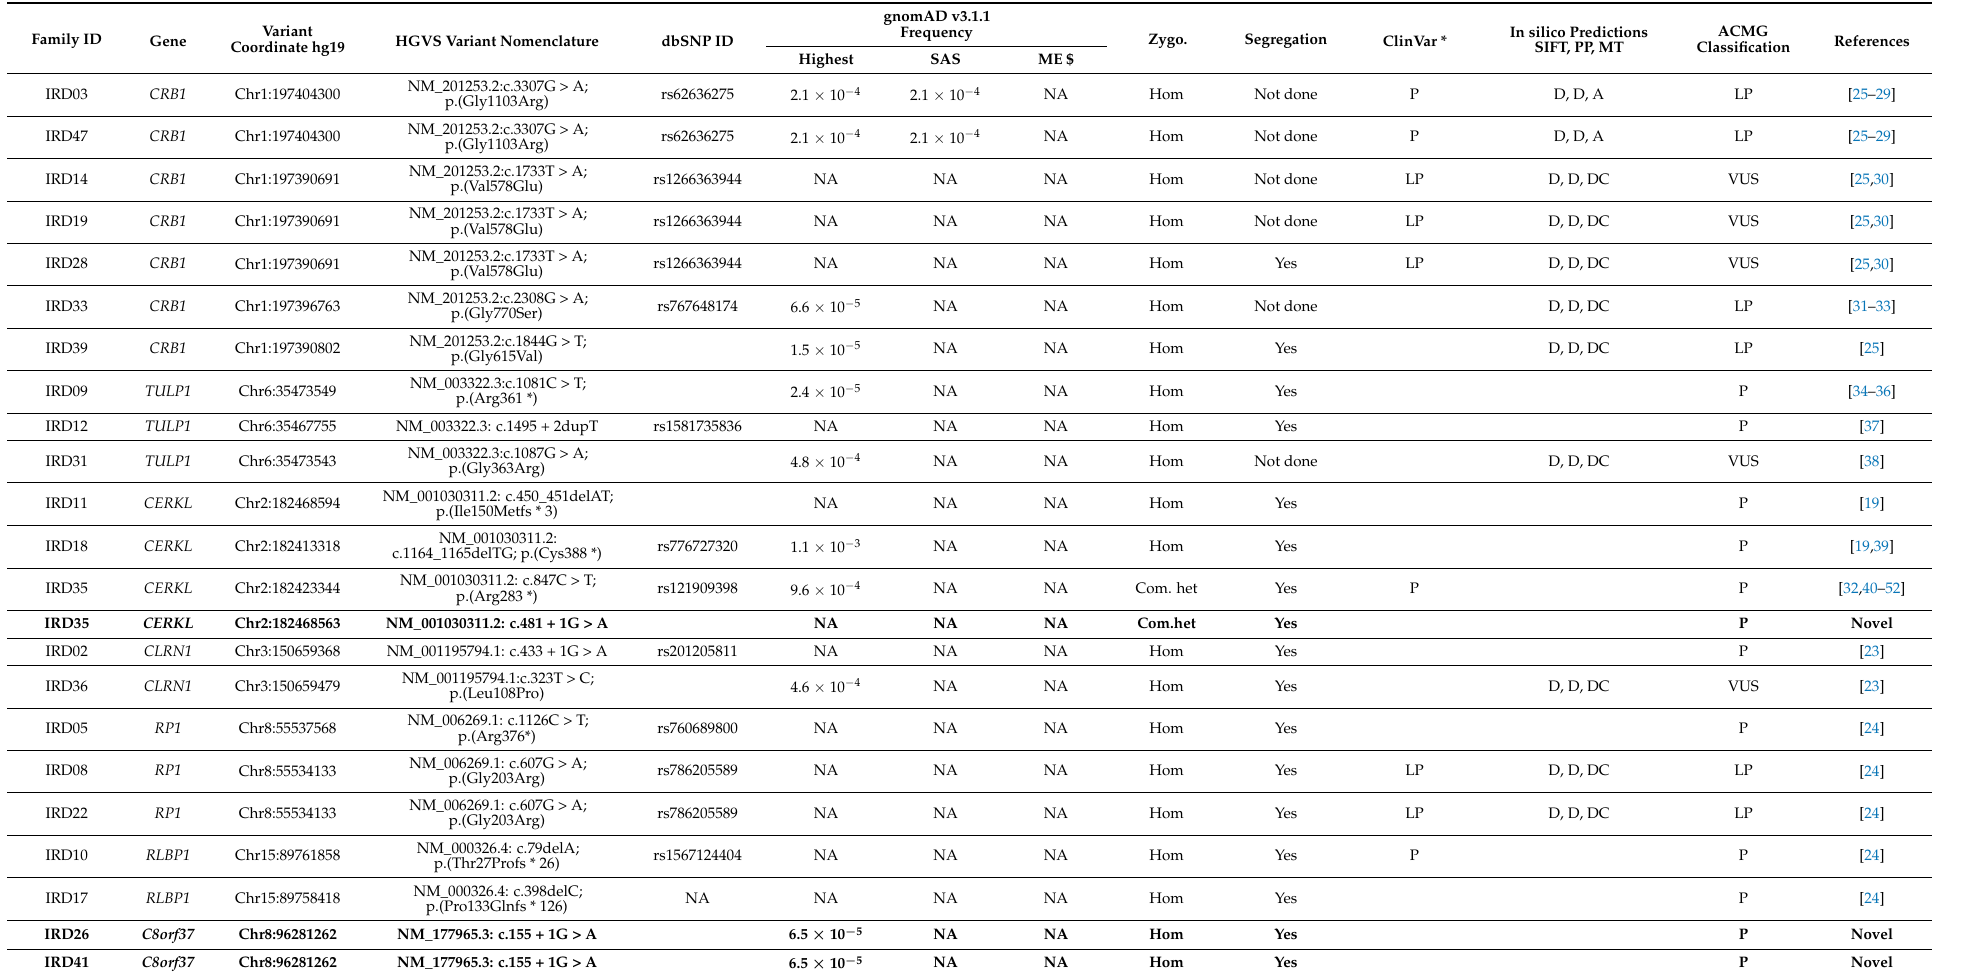
Table 2. Candidate disease variants identified in the Jordanian inherited retinal dystrophies